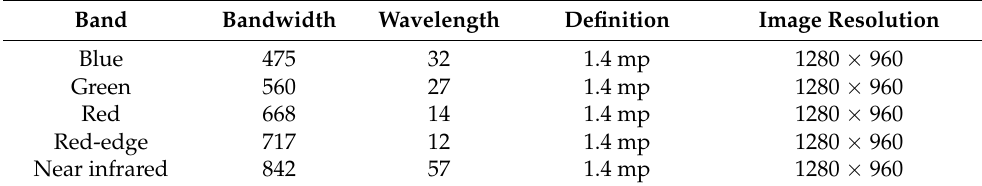
Table 1. Specification of the multispectral camera used in this study.